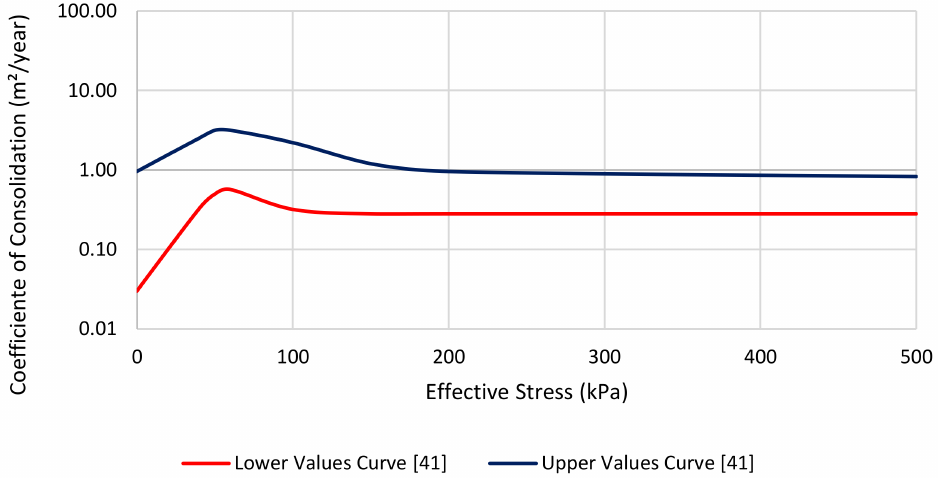
Figure 1. Range of coefficient of consolidation values for clays in the region of Rio de Janeiro obtained from oedometric tests